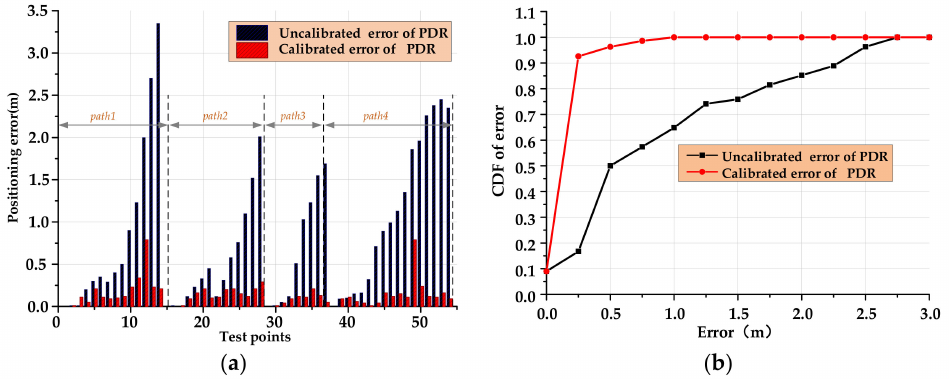
Figure 13. Statistical analysis of small-scale indoor environment: ( a ) linear distance error and ( b ) cumulative error distribution